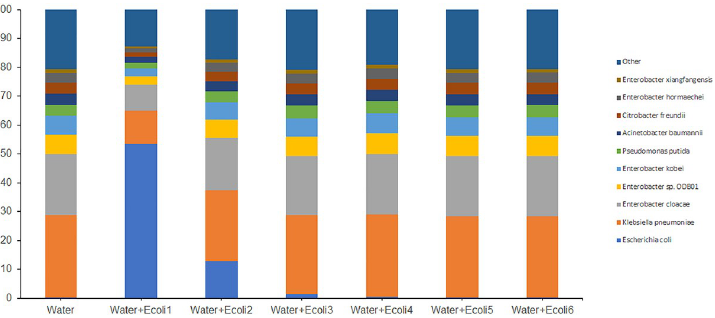
Fig 3. Relative abundance of bacterial species associated with irrigation water un-spiked and spiked with E . coli EDL933_2. Enriched irrigation water (Water) was artificially contaminated with 10-fold dilutions of E . coli EDL933_2 (+Ecoli) with a starting concentration of 7 x 10 8 CFU/ml (Water+Ecoli1). Reads were analyzed by the EPI2ME WIMP workflow. Bacterial species contributing more than 1% of the classified reads are shown and the sum of the remaining species identified are included as